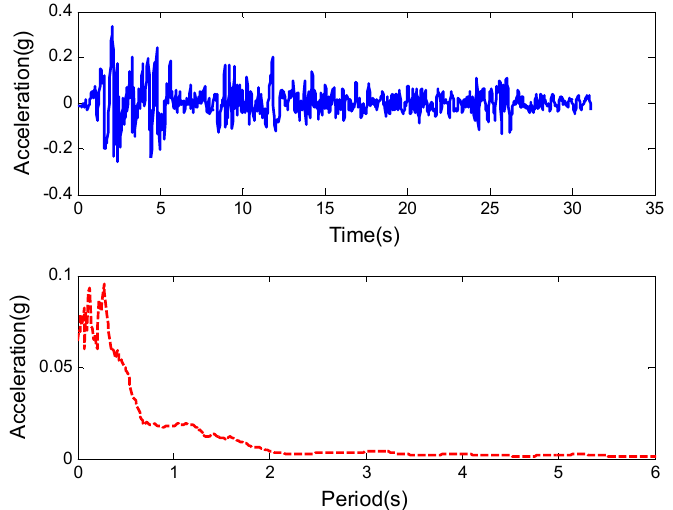
Figure 4. Seismic record (upper) and spectrum (lower) of the 1940 El Centro earthquake (NS).